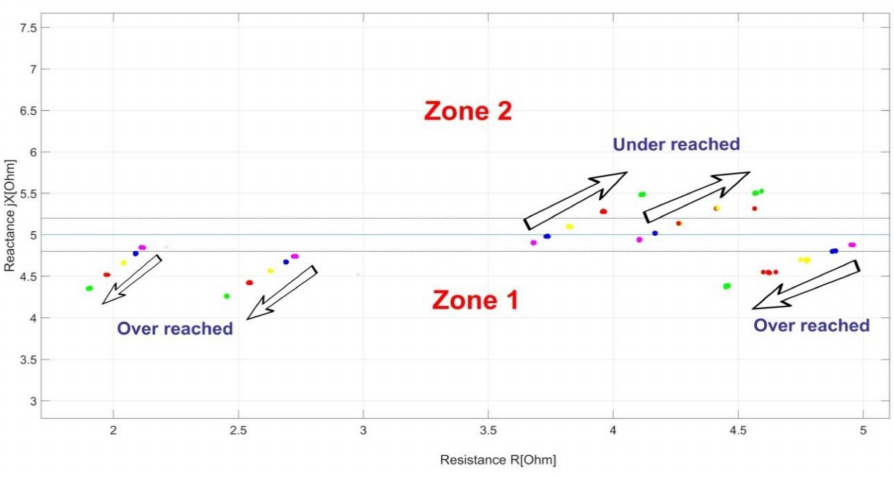
Figure 10. Quadrilateral characteristic and measured fault impedance locus.